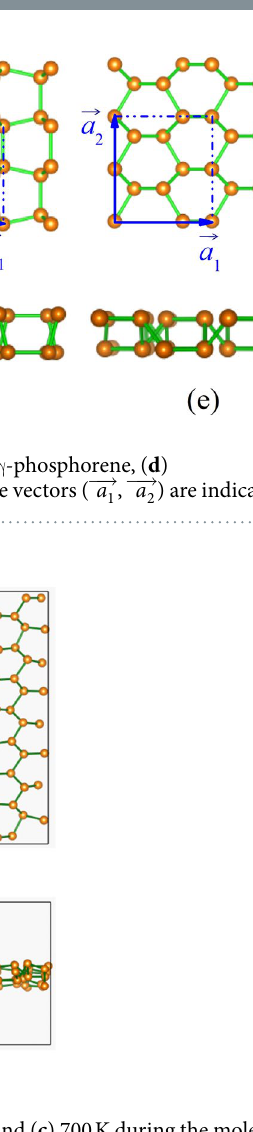
Figure 2. Structural snap shots of the ζ -phosphorene at ( a ) 300 K, ( b ) 500 K, and ( c ) 700 K during the molecular dynamics simulations. The corresponding side-views are shown in ( d ), ( e ), and ( f ),